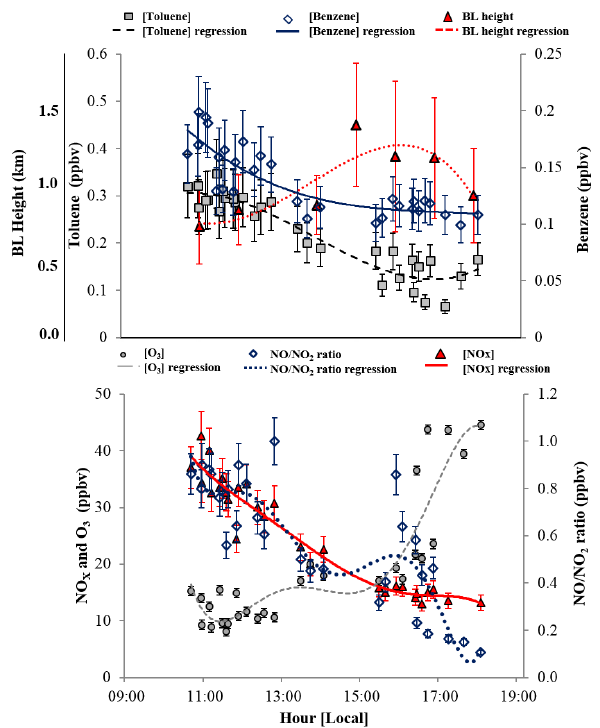
Figure 2. Top: time series of averaged benzene and toluene concen- trations observed at 360 ± 10ma.g.l. during RF 2–6. Bottom: time series of averaged NO/NO 2 ratios and O 3 and NO x concentrations during RF